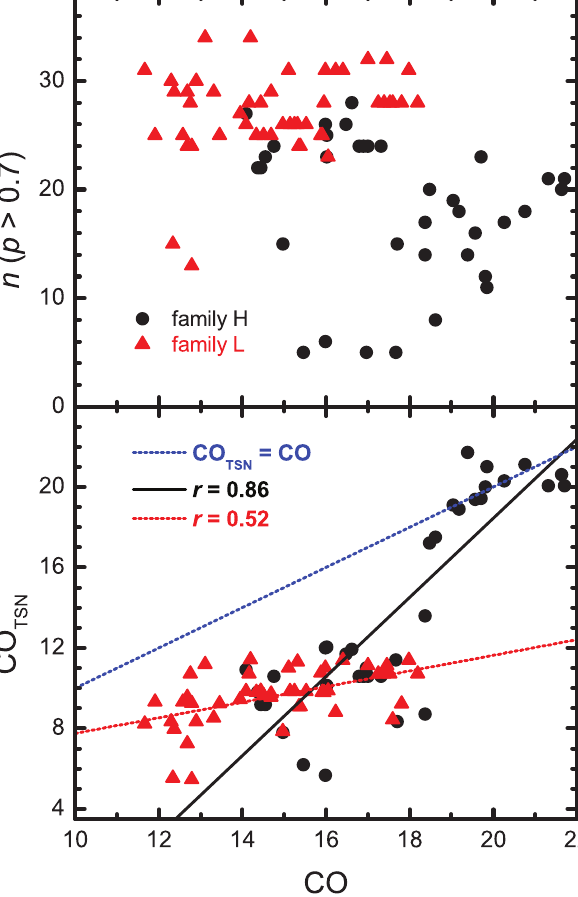
Figure 6. The number of native contacts forming the TSN as a function of CO (top) and the dependence of the contact order of the TSN on the CO (bottom) for families L and H.